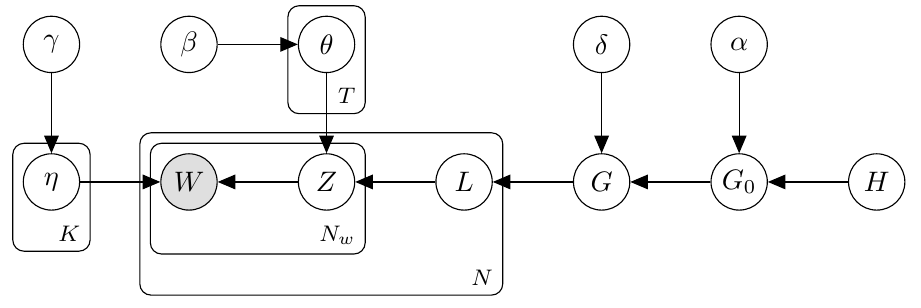
Figure 1. DESTM graphical model. As shown in the graphical model. N means the number of short texts. N w means the number of words in a short text. T means the number of topics and K means the number of vocabulary. Solid node W means words that are known variables. Nodes Z and L are the latent variables that we need to sample. Nodes γ , β , δ , α , and H are prior parameters that we need to define. Nodes θ and η are parameters of multi-nominal distributions. G 0 is a probability measure sampled from the Dirichlet process and a probability measure G is sampled according to prior G 0